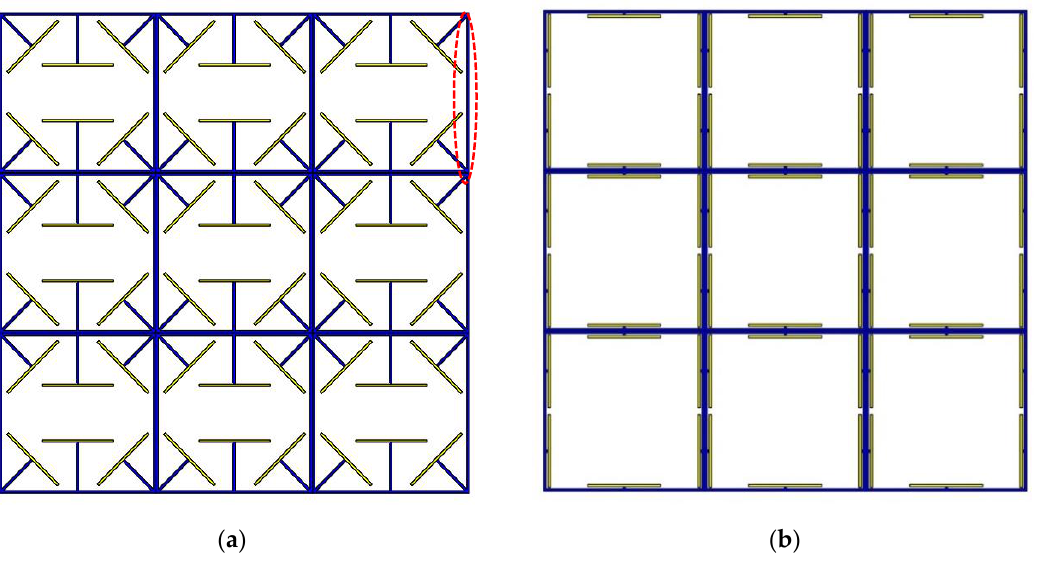
Figure 9. Periodic metastructures with active and passive components: ( a ) diagonal structure; ( b ) parallel structure (the red dashed oval shows the fixed-fixed beam used for the frequency normalization).